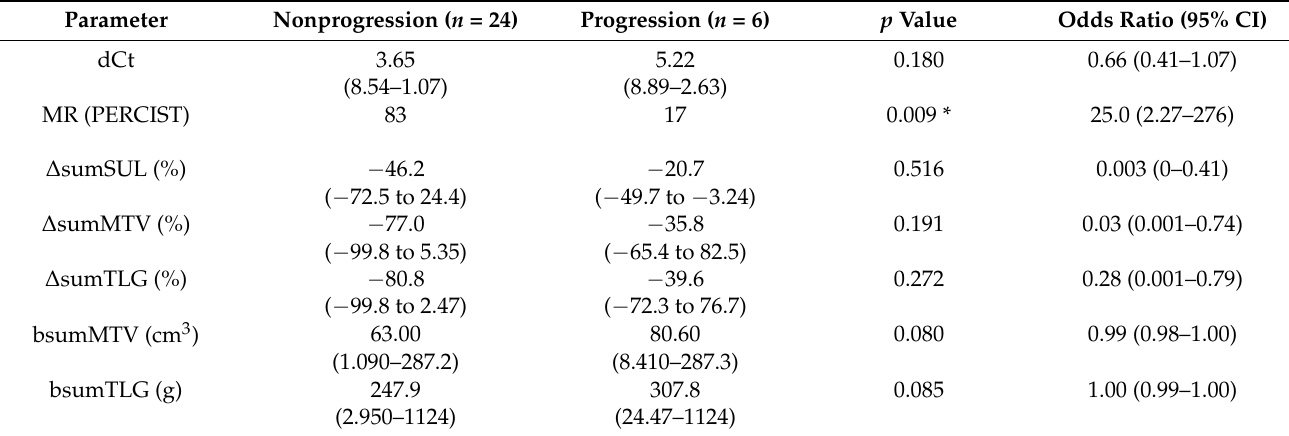
Figure 1. Patient flow diagram. Table 2. Multivariate analysis of parameters and association with nPD 3mo ( n = Table 1. Patient characteristics.